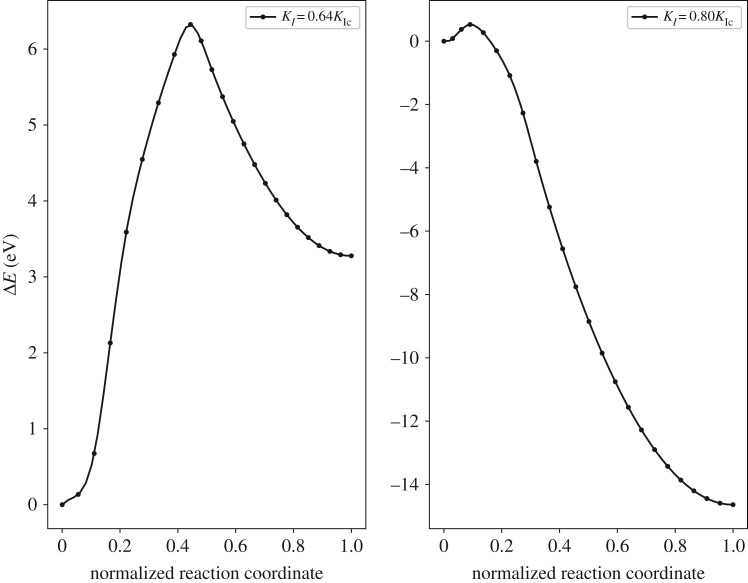
Minimum energy paths for dislocation nucleation in Ni at KI = 0.64KIc and KI = 0.80KIc.